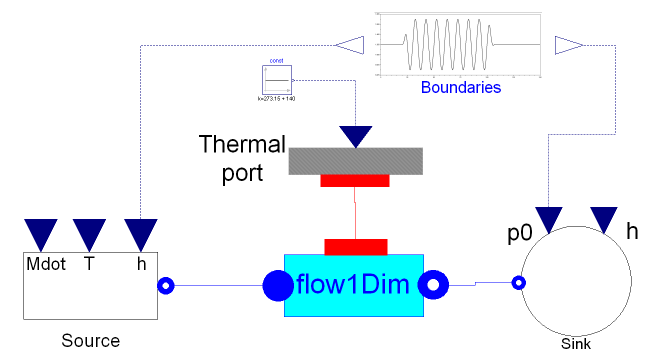
Figure 3. Modelica diagram of the test